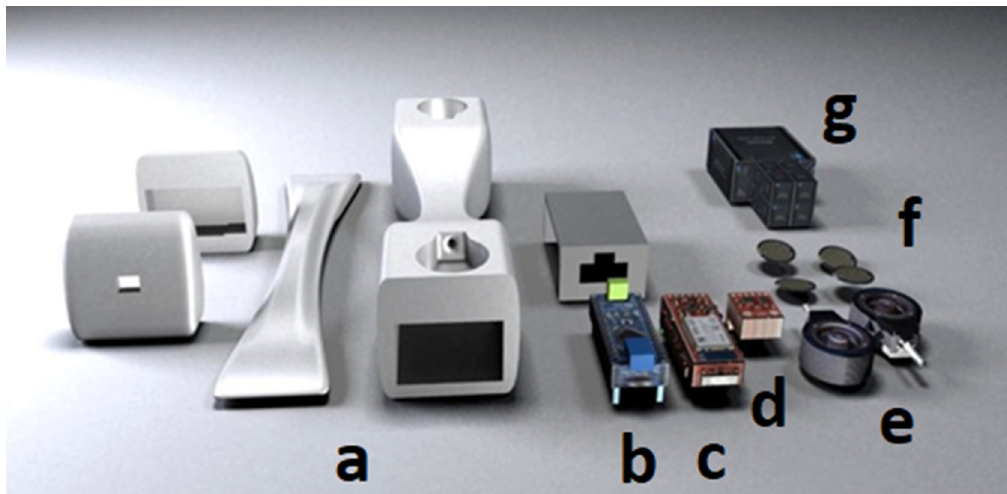
Figure 1. Shaders prototype and their components: ( a ) controller case, ( b ) Arduino, ( c ) Instrumentation Amplifier (AD627), (d) IMU sensor, ( e ) force sensors, ( f ) Interlink FSR sensor, and ( g ) battery.